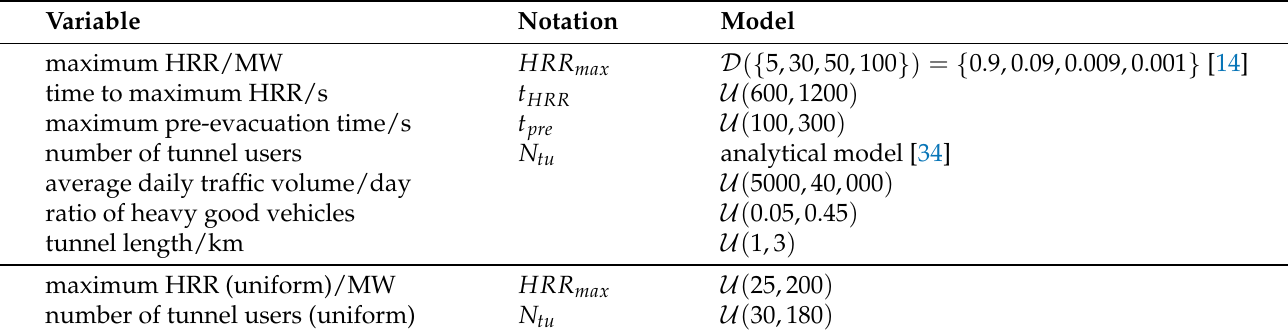
Figure 1. Geometry of the road tunnel applied for the risk analysis. Table 2. Probability distributions of variables used for the risk analysis (above); and additional uniform distributions U for HRR max and N tu (below) for the evaluation of the